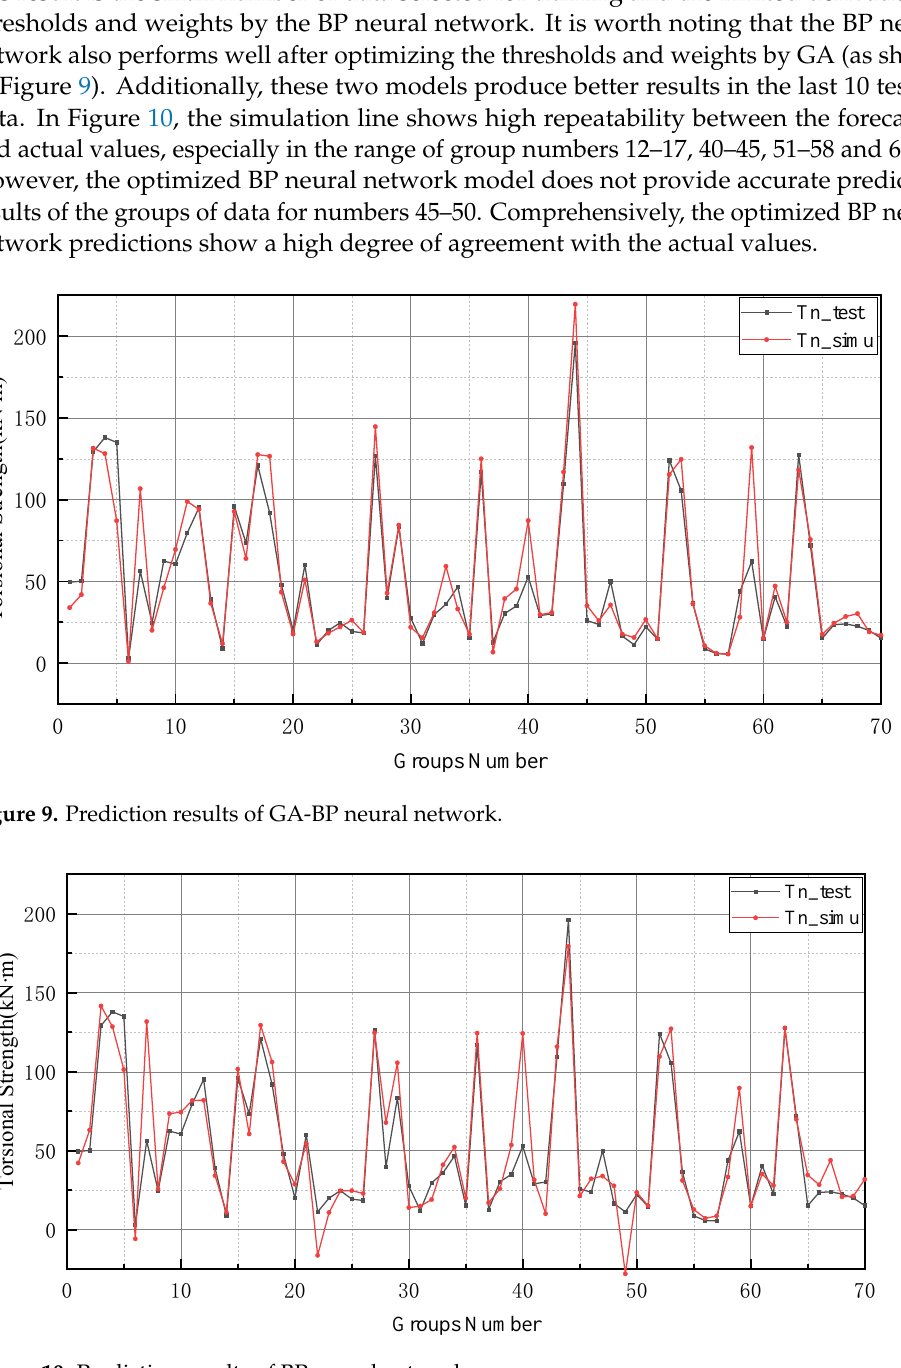
Figure 10. Prediction results of BP neural